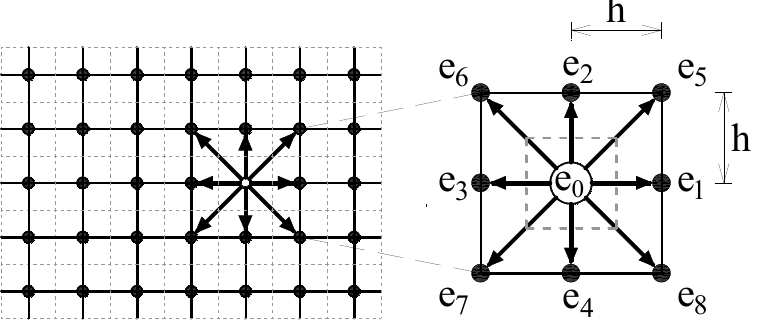
Figure 1. Discretization of the computational fluid field into h × h ( h is lattice spacing) square lattices using D2Q9 velocity set (nine velocities in 2D).